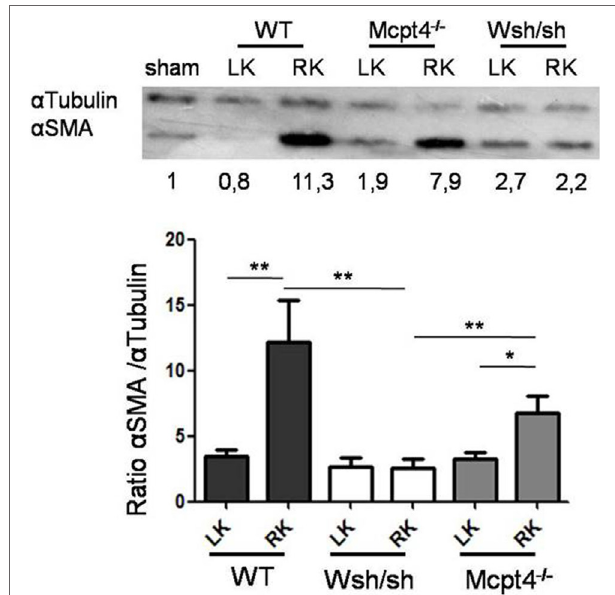
FigUre 6 | evaluation of α -sMa expression in kidney parenchyma after partial unilateral ureteral obstruction . Upper panel shows representative western blot analysis of α -SMA expression in kidney parenchyma in WT (17), MC-deficient (10), and MCPT4-deficient (17) mice at D75 post-surgery. At D75 post-surgery, cell lysates were prepared from left and right kidneys and submitted to western blotting using an anti- α -SMA antibody. Anti-tubulin was used for analysis of equal loading. Numbers below the blot indicate ratio of α -SMA versus α -tubulin as compared to a sham kidney mouse used as a universal control in each gel and arbitrarily set to 1. Lower panel shows quantitative analysis of western blots. Data are the mean ± SEM of the indicated numbers of mice, ** p ≤